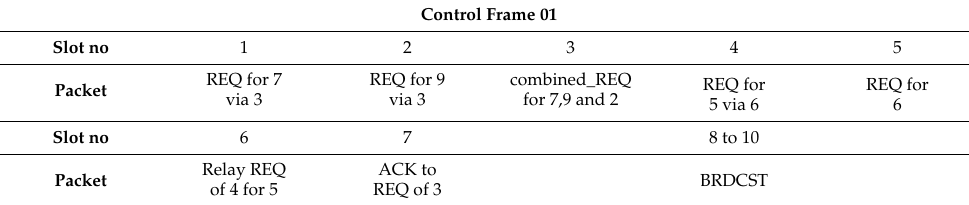
Table 6. First control frame contains transmissions of all software-defined radios (SDRs).